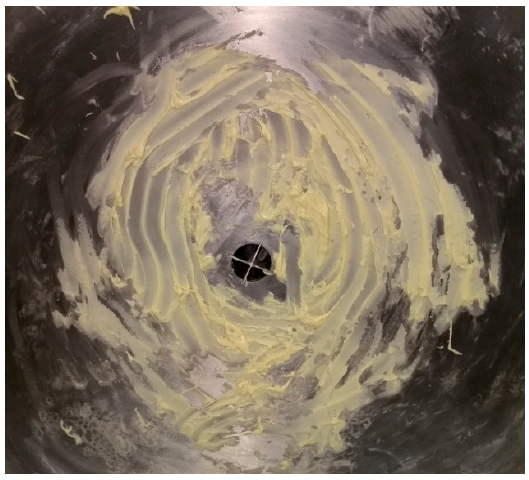
Figure 6. Deposited white chocolate fouling.